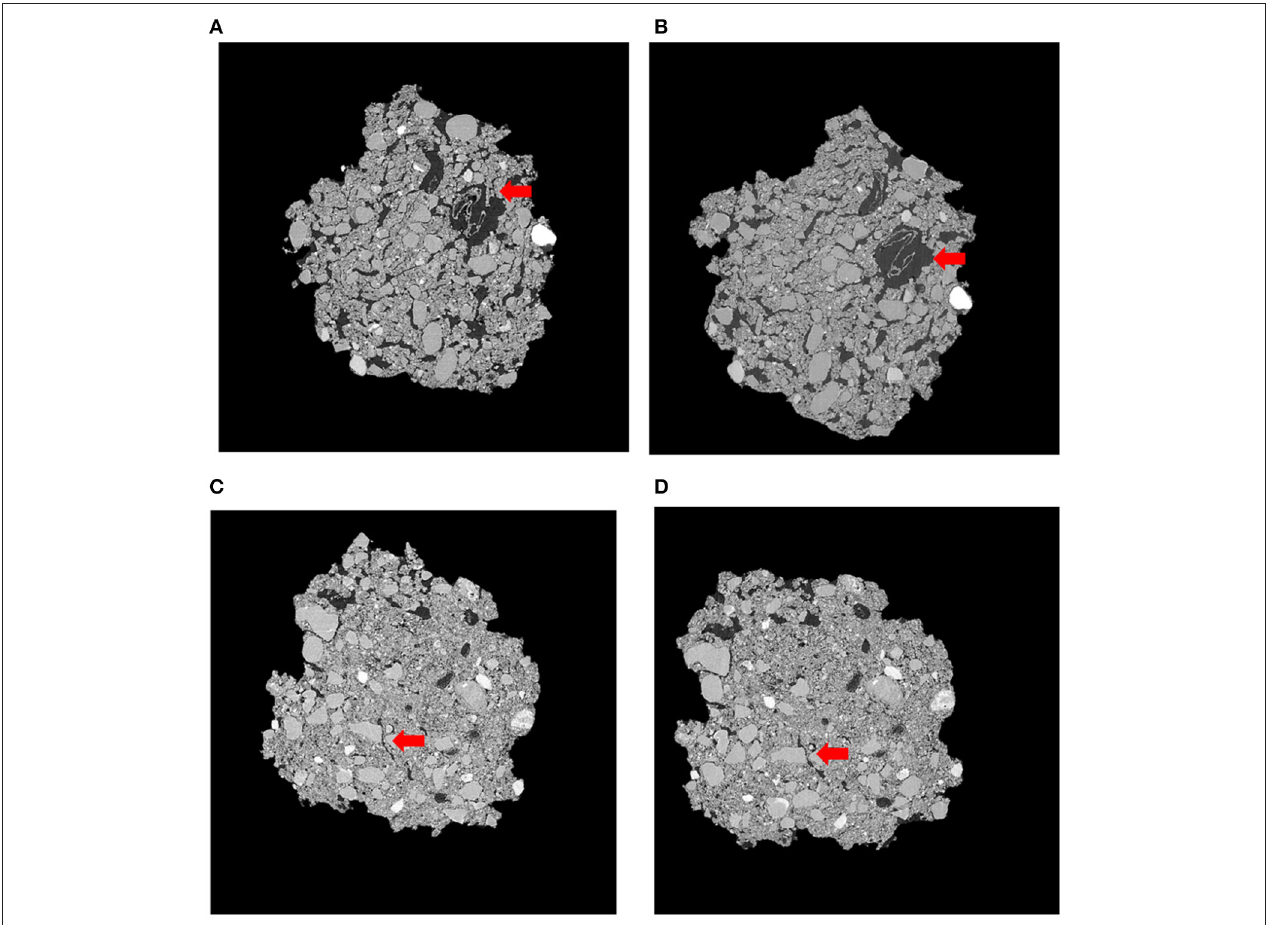
FIGURE 3 | Representative slices of the same soil fragment for Pre-Intact (A) , Post-Intact (B) , Pre-Destroyed (C) , and Post-Destroyed (D) . Red arrows highlight an area where porosity visibly increased during incubation. Each soil fragment is approximately 5mm